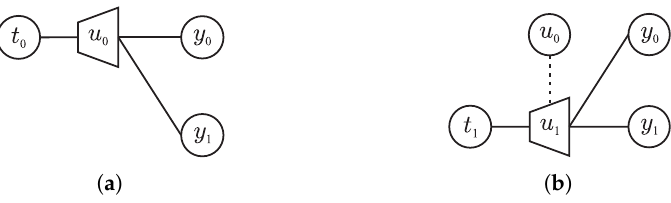
Figure 5. Information bottleneck graph for ( a ) the bit channel of u 0 which maps outputs y 0 , y 1 onto |T | clusters, labeled t 0 , treating u 0 as the relevant variable. ( b ) The bit channel of u 1 which maps the outputs y 0 , y 1 , u 0 onto |T | clusters, labeled t 1 , treating u 1 as the relevant